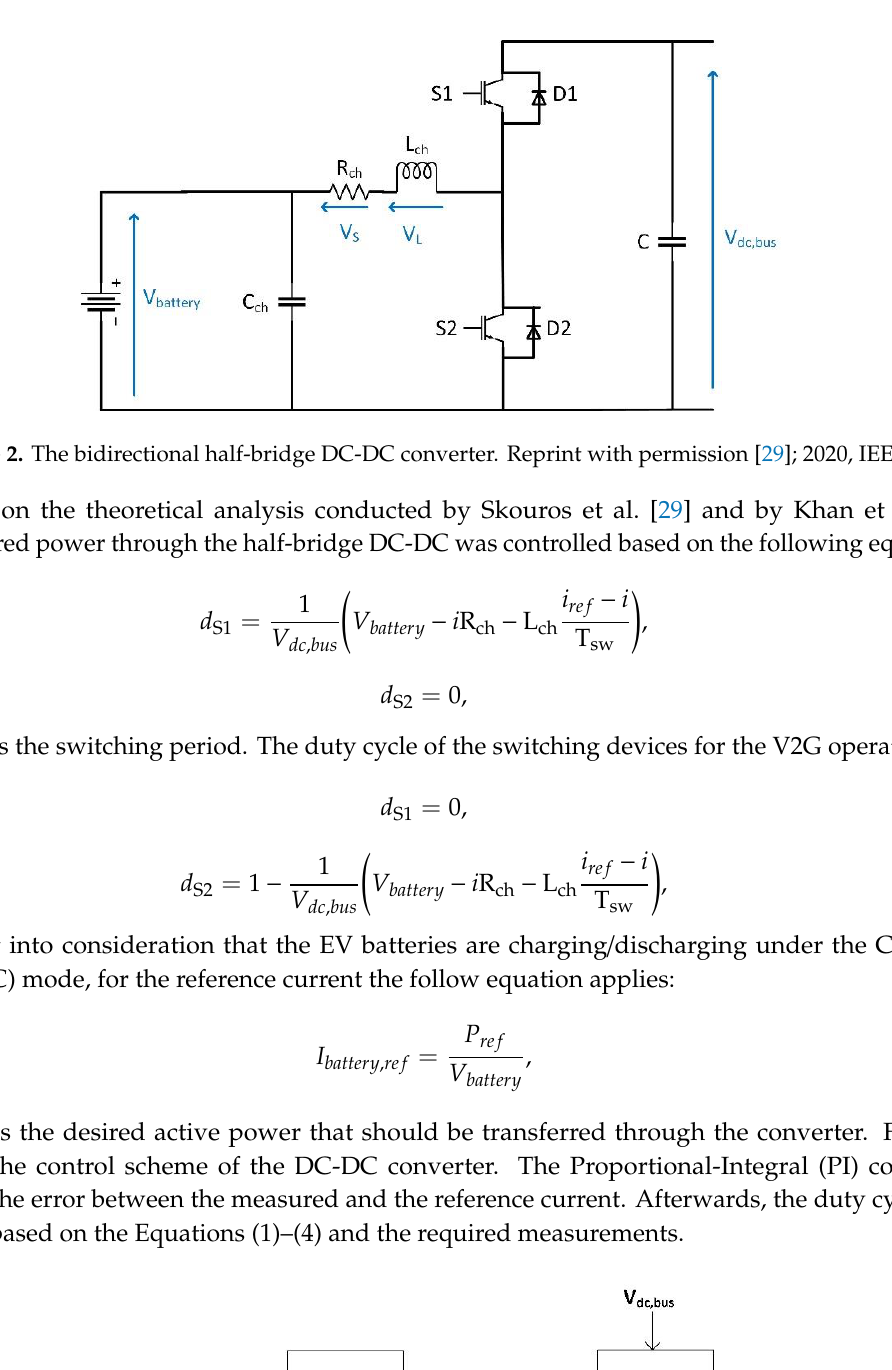
Figure 3. The control scheme of the bidirectional charger. Reprint with permission [29]; 2020, IEEE.